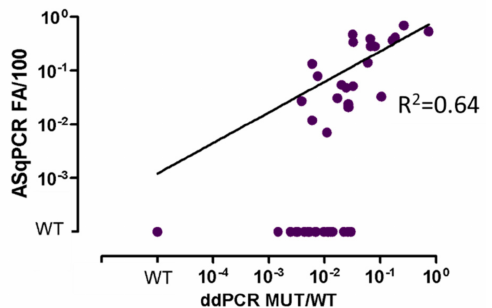
Figure 4. ASqPCR vs. ddPCR in cfDNA from plasma samples. Comparison between ASqPCR and ddPCR for MYD88 L265P detection in terms of ratio between MUT and WT in 32 WM, 4 IgM-MGUS, and 28 Lymphomas, 47 at diagnosis and 17 at FU. WT: Wildtype (quantitative value outside the limit of blank. Limit of blank was calculated based on healthy subjects as the mean value +1 SD); 10 − 4 : 1 × 10 − 4